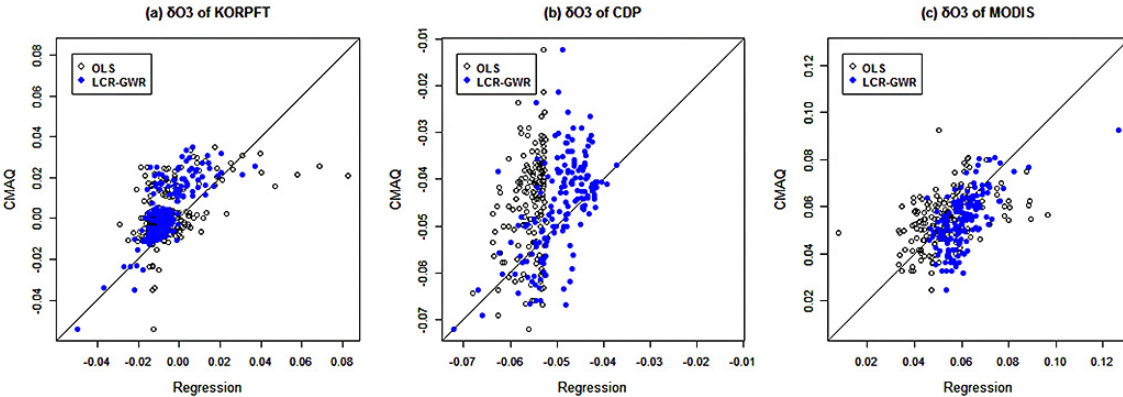
Figure 8. CMAQ-derived δ O 3 vs. the fitted δ O 3 under each regression model for three PFT scenarios.